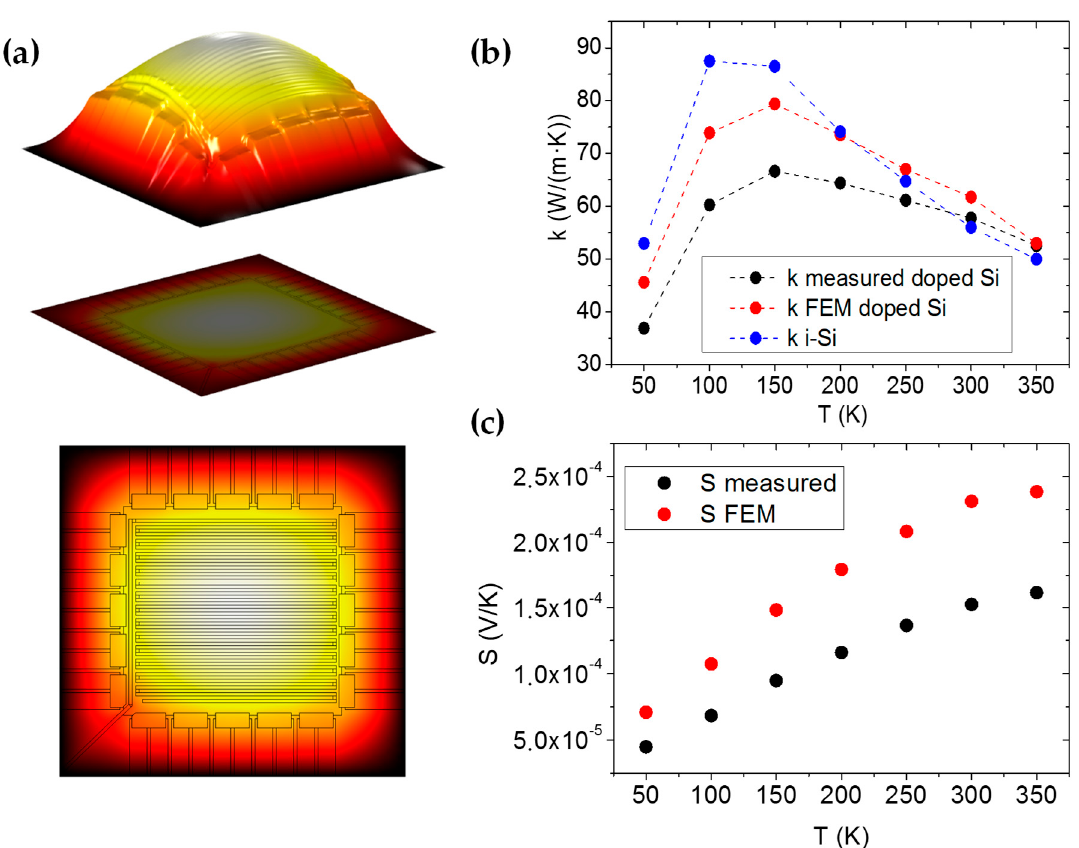
Figure 3. ( a ) Temperature distribution in the TEG (white is hot). ( b ) Comparison between the measured thermal conductivity k, the modeled one and an intrinsic Si film. ( c ) Comparison between the measured Seebeck coefficient k and the modeled coefficient.